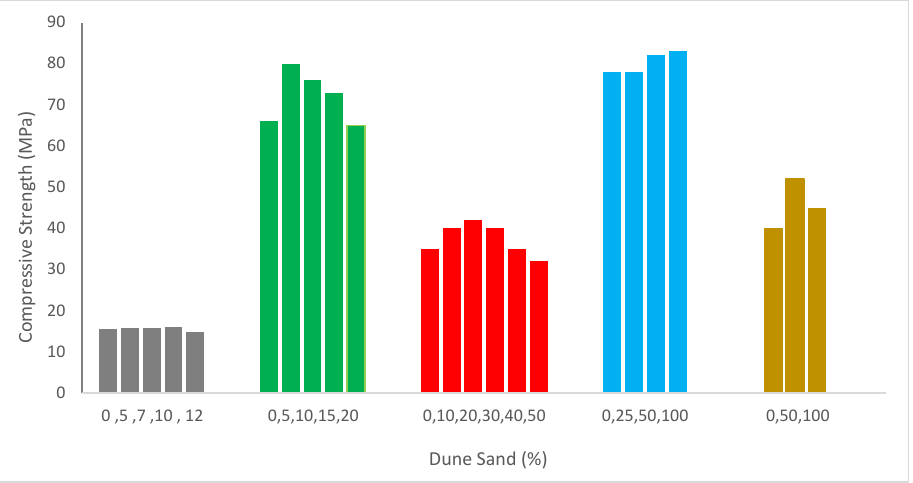
Figure 4. Compressive strength: data source [10,47 – 49,58].